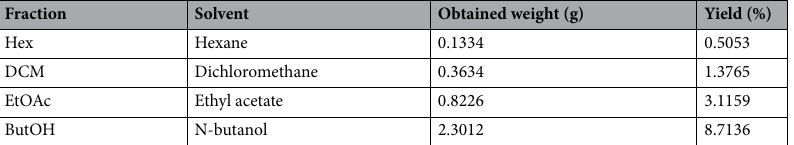
Table 2. Liquid–liquid partitioning yield from kefir methanolic extract, starting from 100 g of lyophilized kefir (fermented